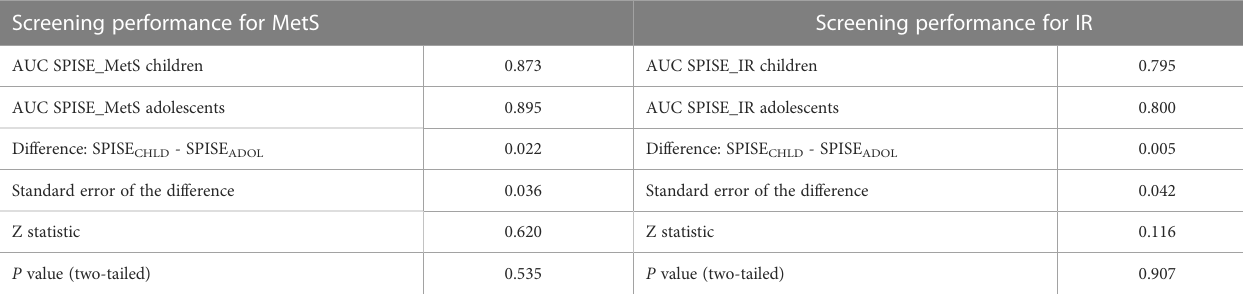
TABLE 3 ROC Curves comparison for MetS and IR screening: children vs. Adolescents.